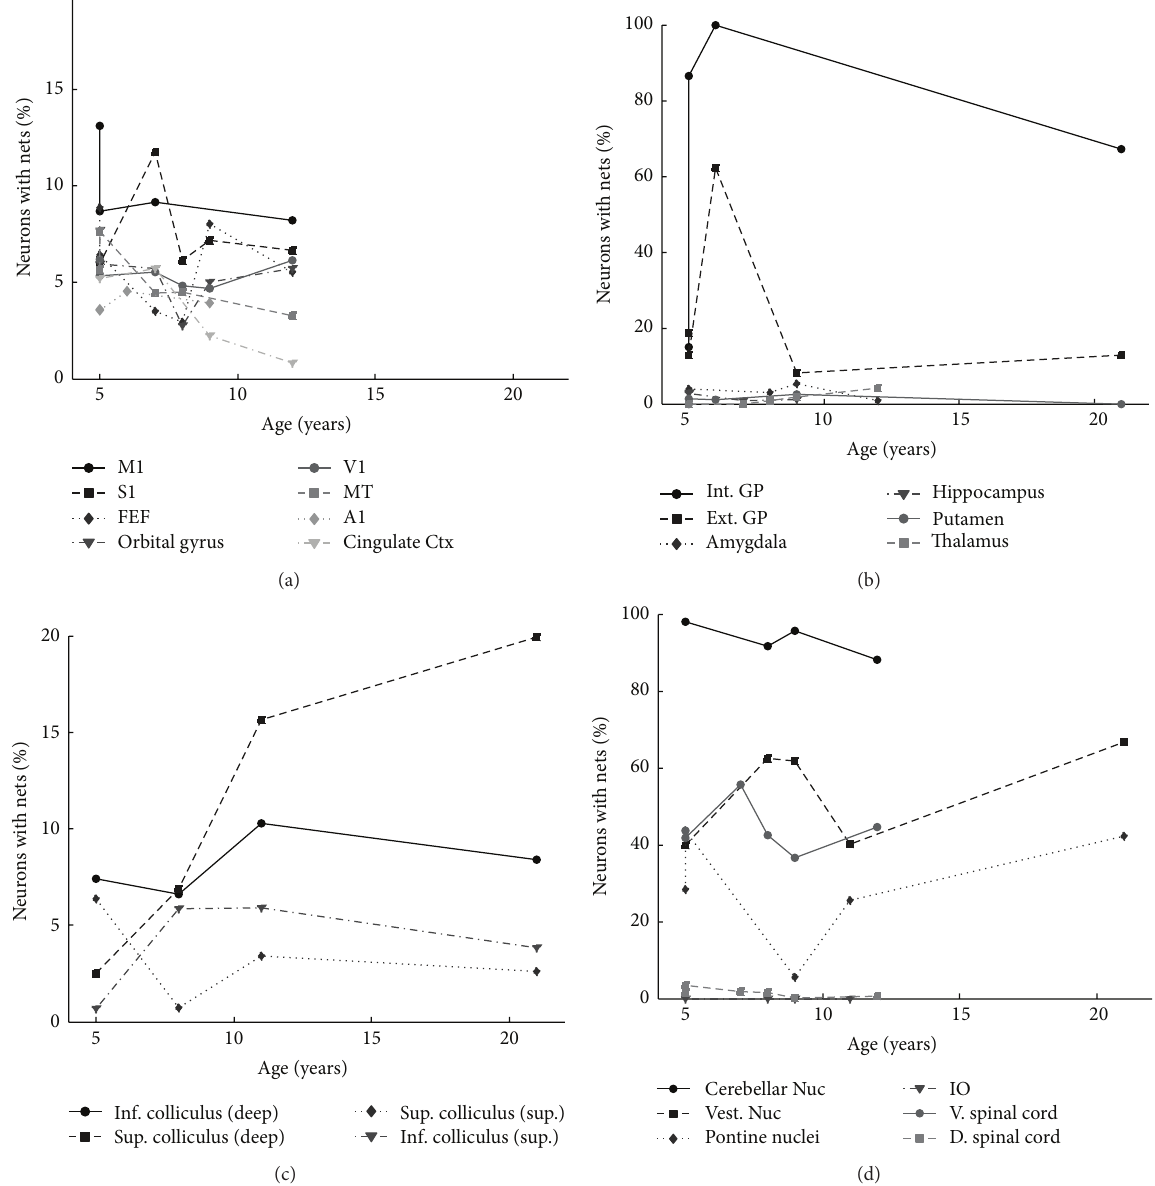
Figure 11: Percentage of neurons with PNNs across animals of different ages. Percentage of neurons surrounded by PNNs in (a) the cerebral cortex, (b) subcortical structures, (c) the colliculi, and (d) the cerebellar nuclei, brainstem, and spinal cord. Each symbol represents a different area in the subplot (see